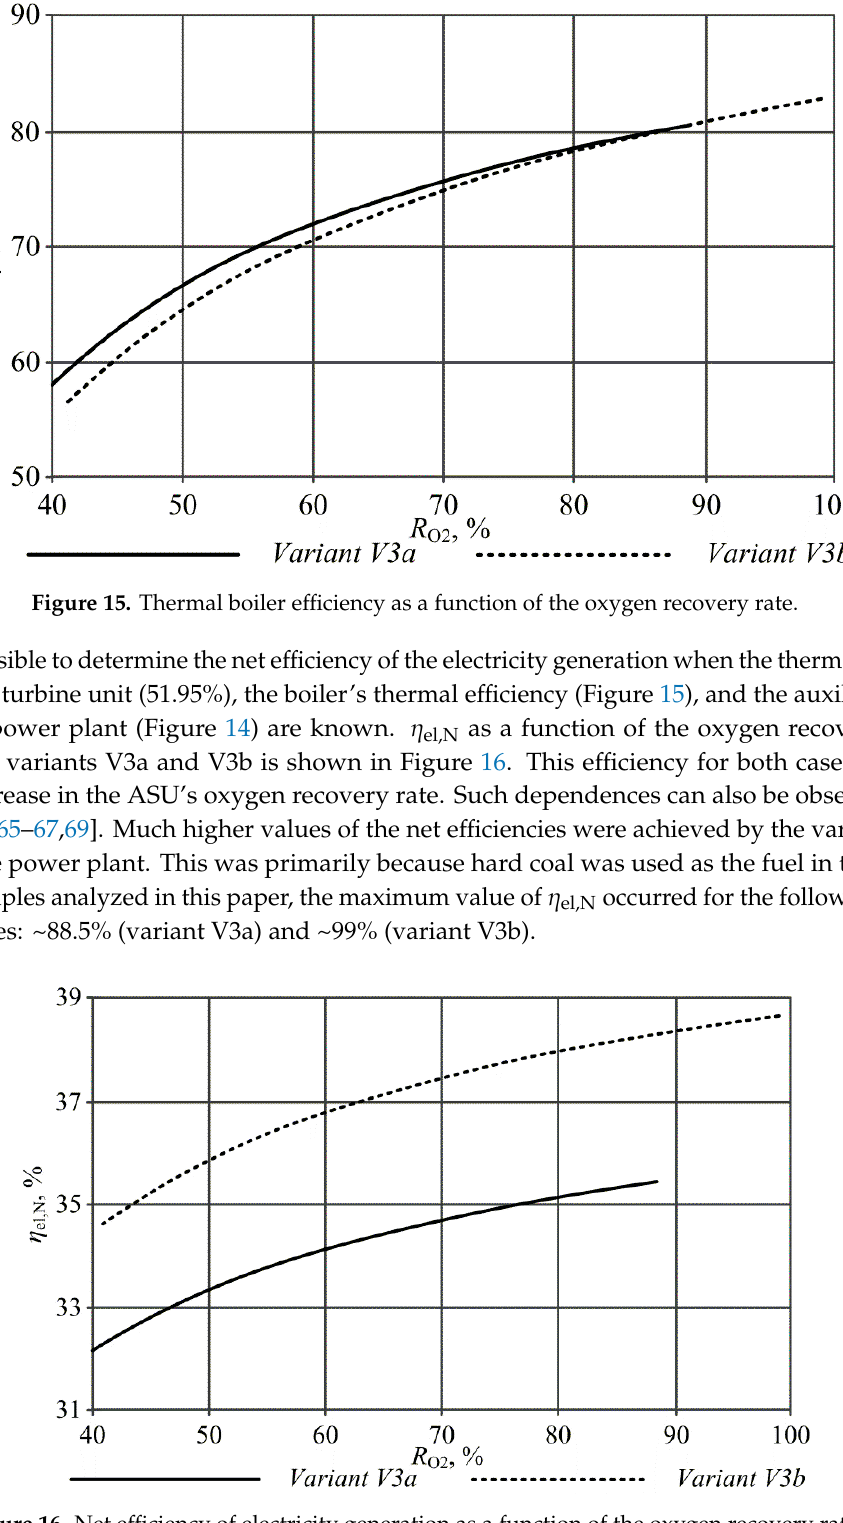
Figure 14. Oxy-type power plant auxiliary power rate as a function of the oxygen recovery rate.